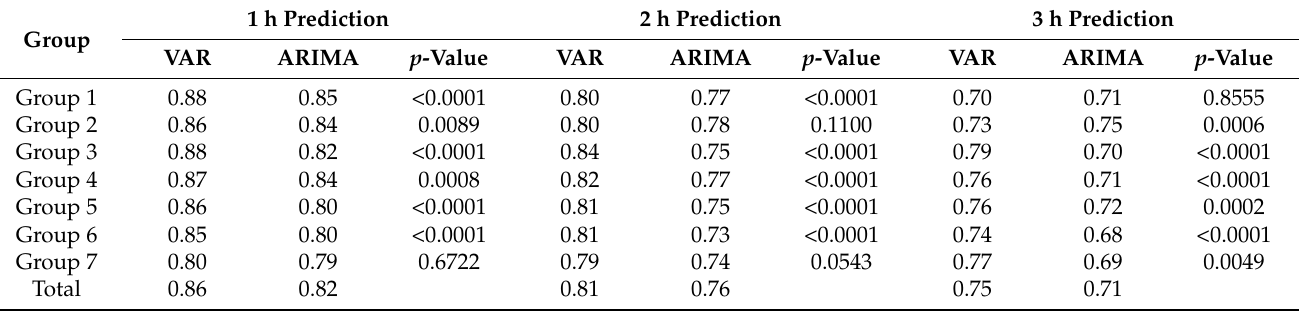
Table 7. Comparison of the VAR and ARIMA models based on 𝑅 2 for 1 ‒ 3 h advance power forecasting.